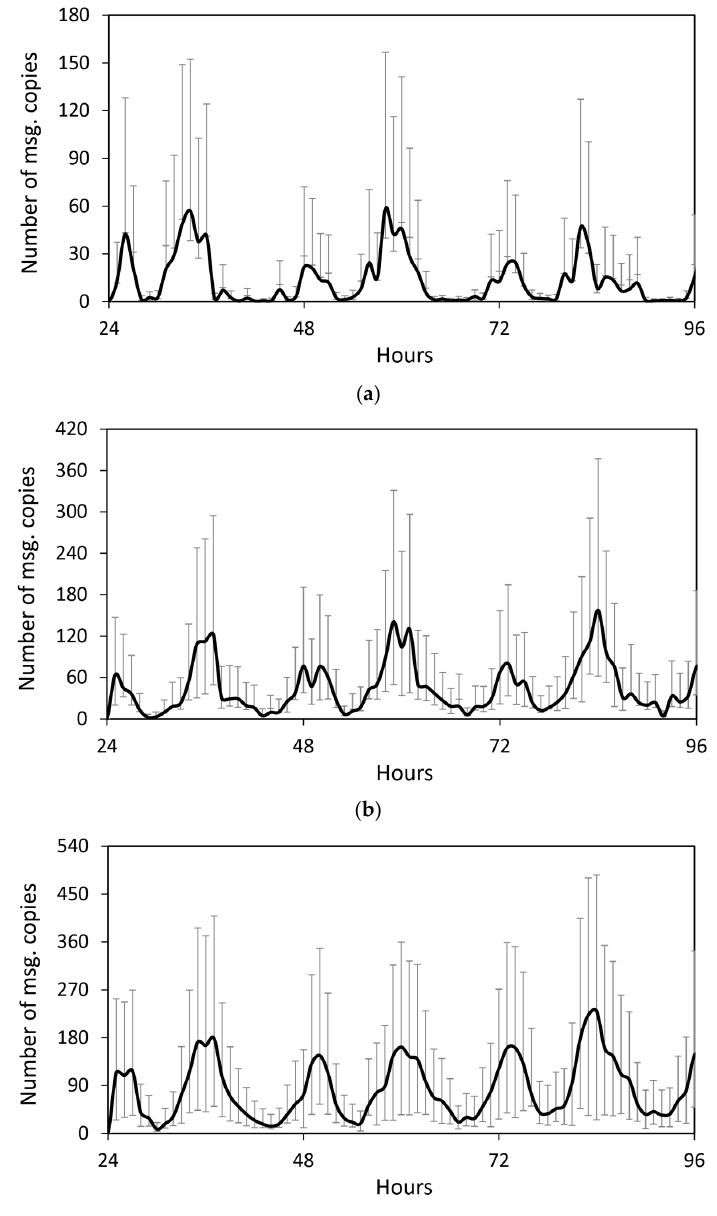
Figure 7. The number of messages replicated per hour with n-Epidemic ( n = 3) under the ( a ) small ( b ) medium and ( c ) large scenario.